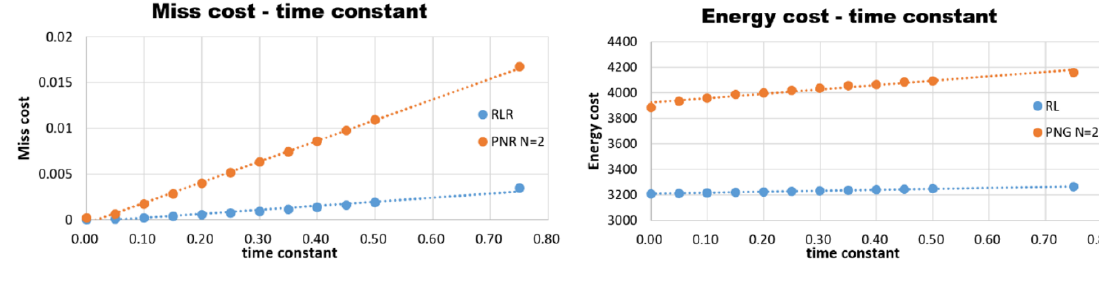
Figure 13. Cost trend for various 𝜏 (N = 2)